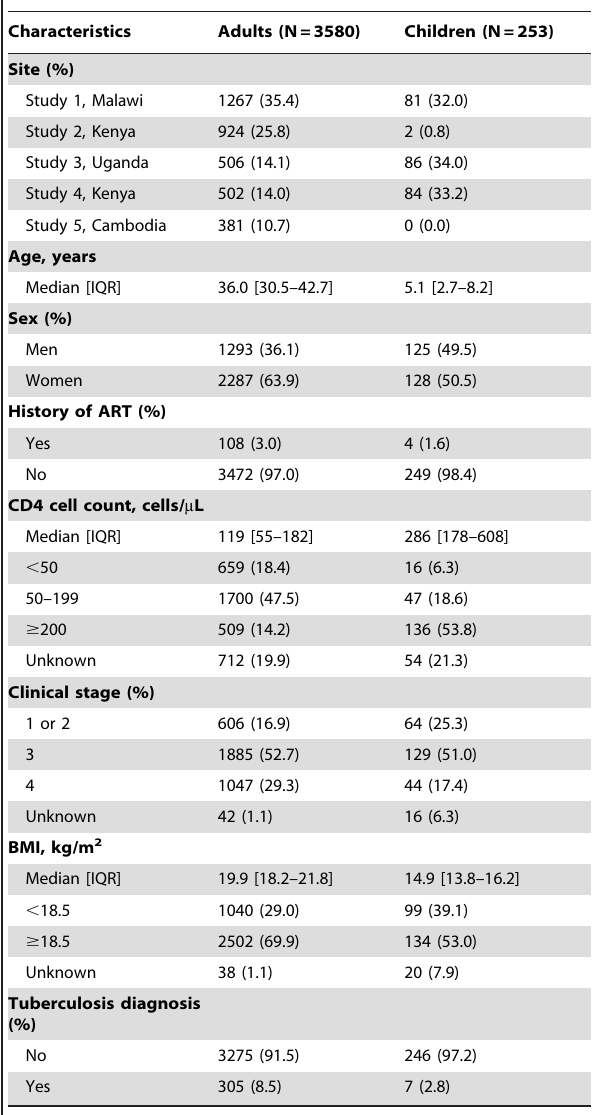
Table 1. Patient characteristics at ART start by age.